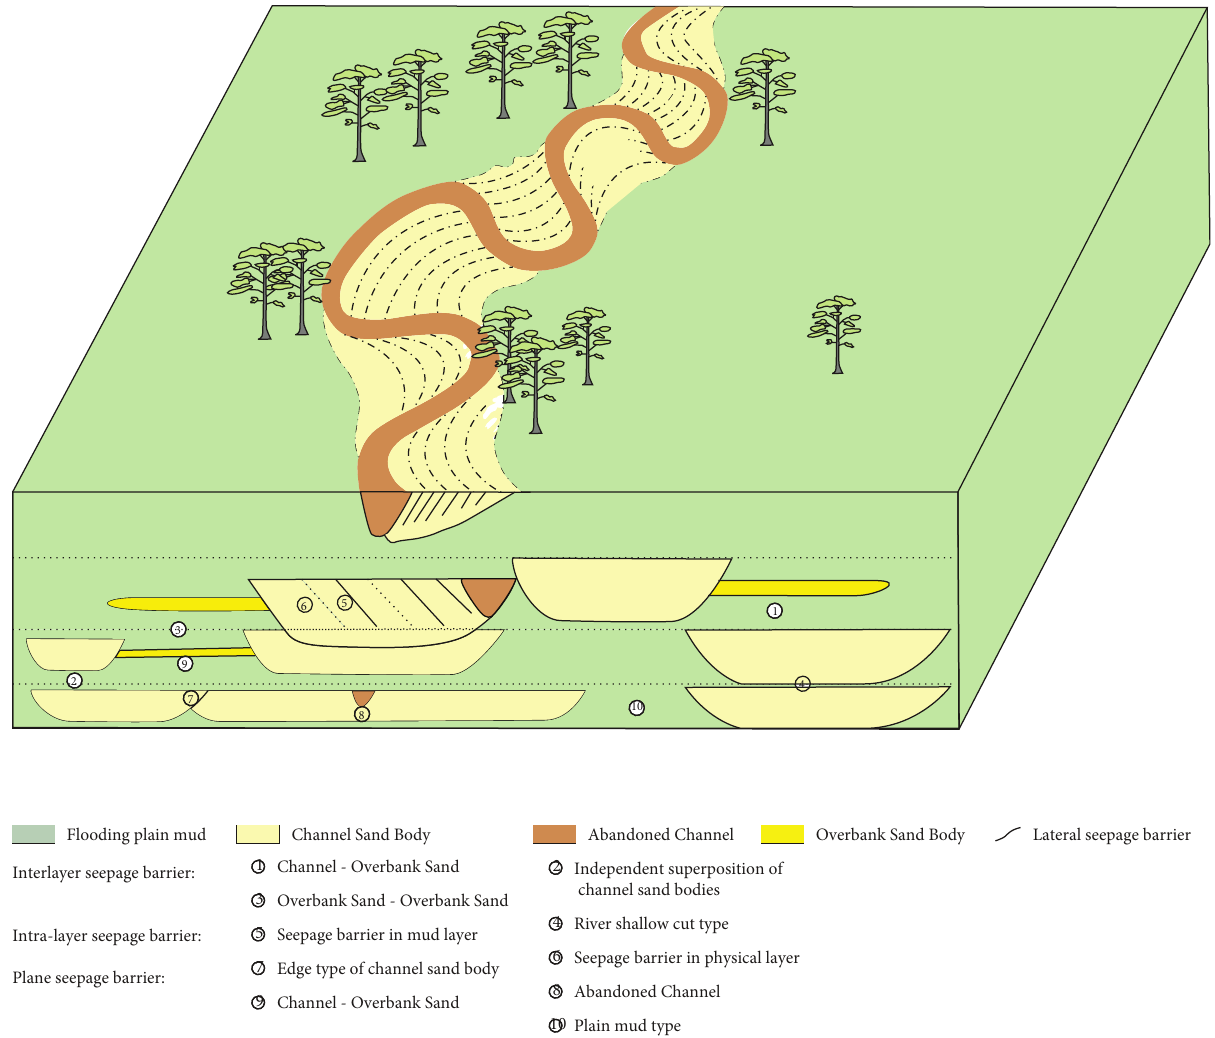
Figure 11: Water injection profiles in different periods under the control of interlayer seepage